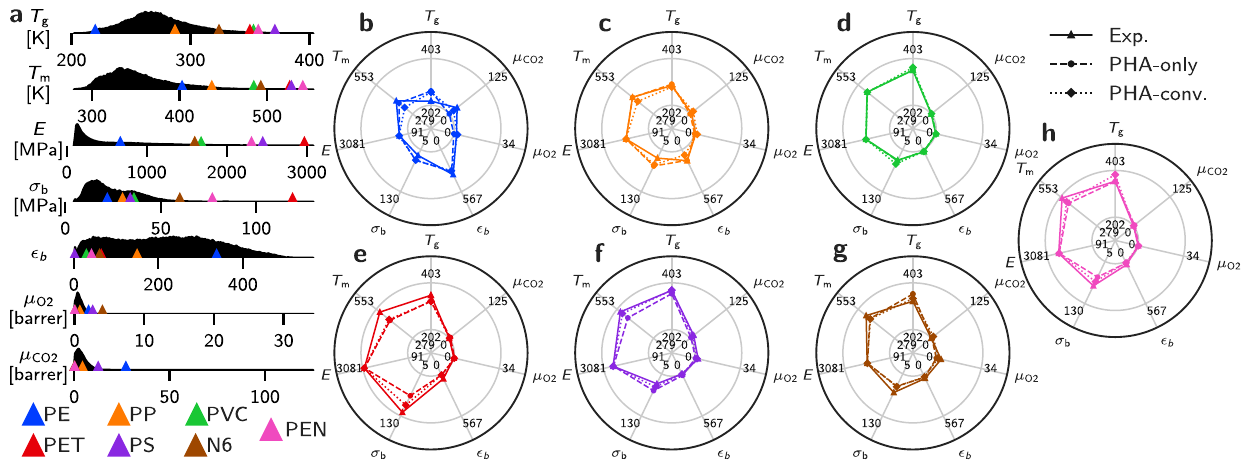
Fig. 5 Experimental and predicted properties. a Property density pro fi les computed over the entire prediction set of bioplastic candidates. Missing x-axes beyond a certain cutoff indicate zero predicted property densities over those property ranges. The triangles show experimental properties of the seven commodity plastics. Full polymer names are listed in Table 3. b – h Property radar charts for each commodity plastic. Triangles with solid lines show the experimental properties. Circles with dashed lines and diamonds with dotted lines indicate predicted properties of the bio-replacements in Fig. 4 for the copolymer subgroups of PHA-only and PHA-conventional polymers,